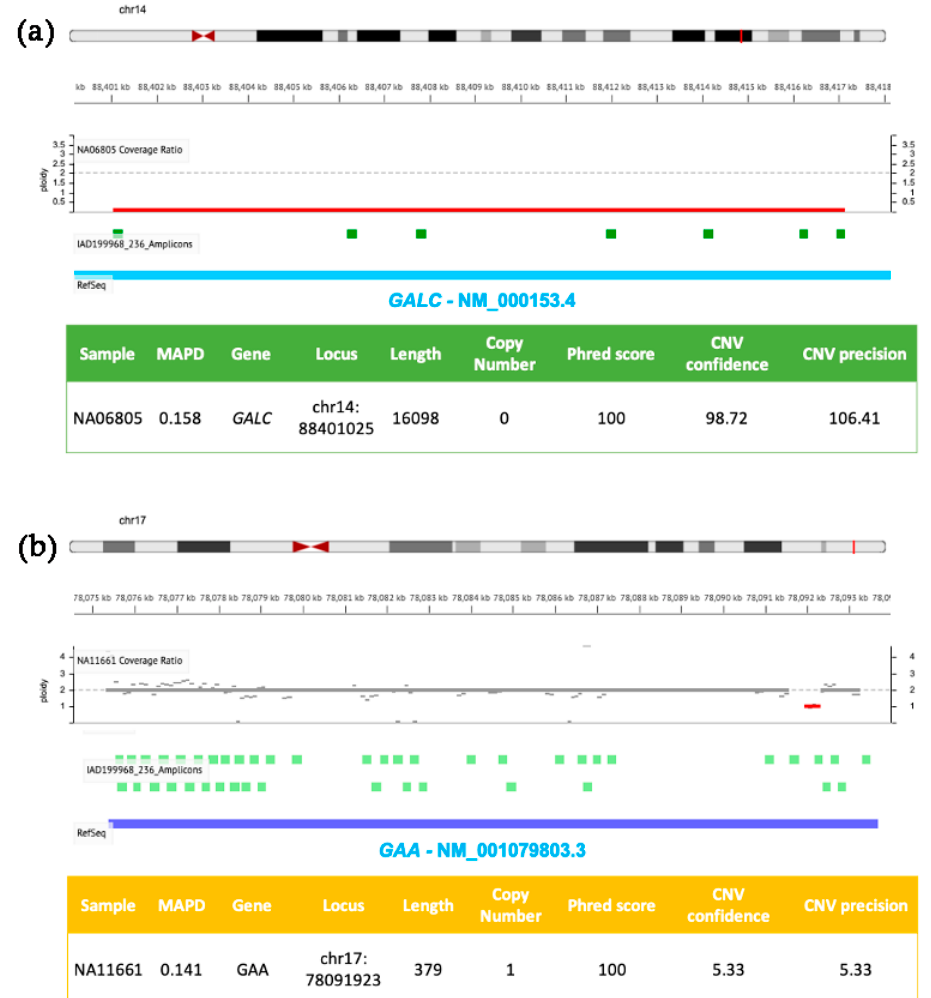
Figure 2. Molecular details of CNVs detected in GALC and GAA by NGS. DNA samples (NA06805 in ( a ) and NA11661 in ( b )) were isolated from clinically diagnosed donor subjects obtained from the NIGMS Human Genetic Cell Repository at the Coriell Institute for Medical Research. Targeted NGS analysis was performed by using the tNGS panel previously described [5] and analyzed with the Ion Reporter Software (default parameters for germline CNVs were as described in Figure 1 with the exception of panel b, where CNV Confidence > 5 and CNV precision >